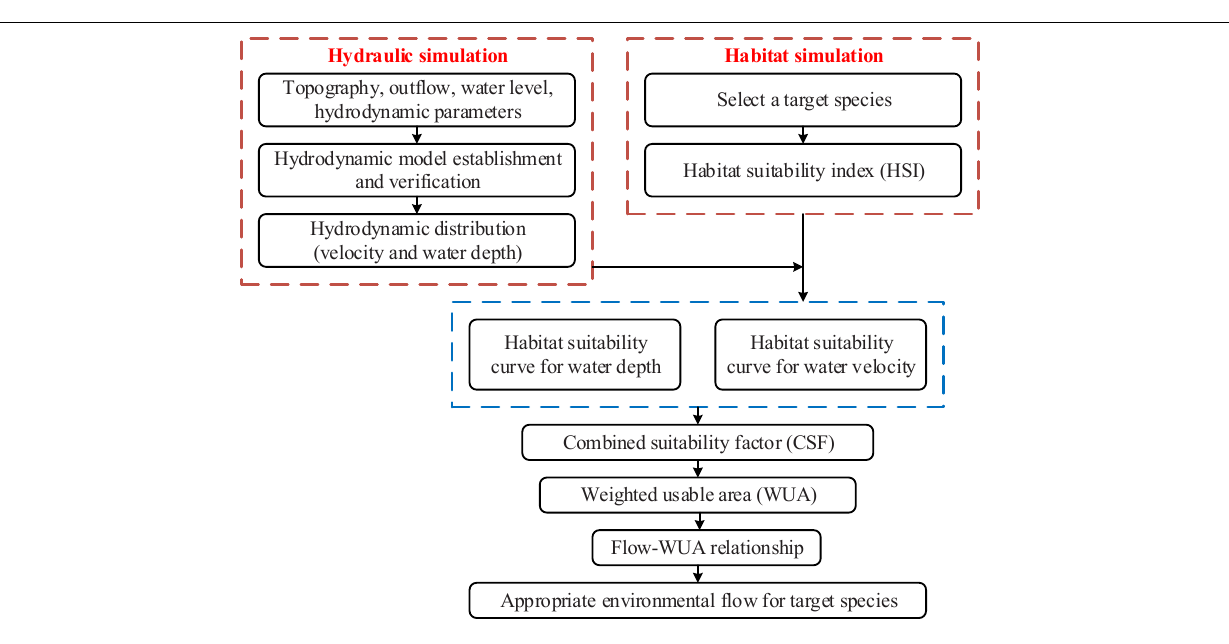
FIGURE 5 | Flow chart for solving the appropriate environmental flow based on the physical habitat simulation model